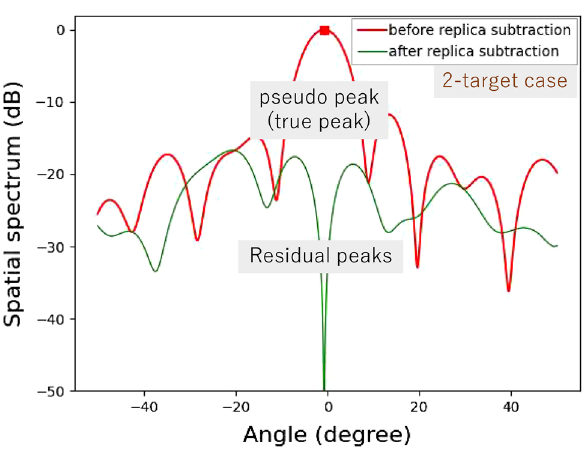
Figure 11. Experimental results for horizontal angle estimation for a two-target